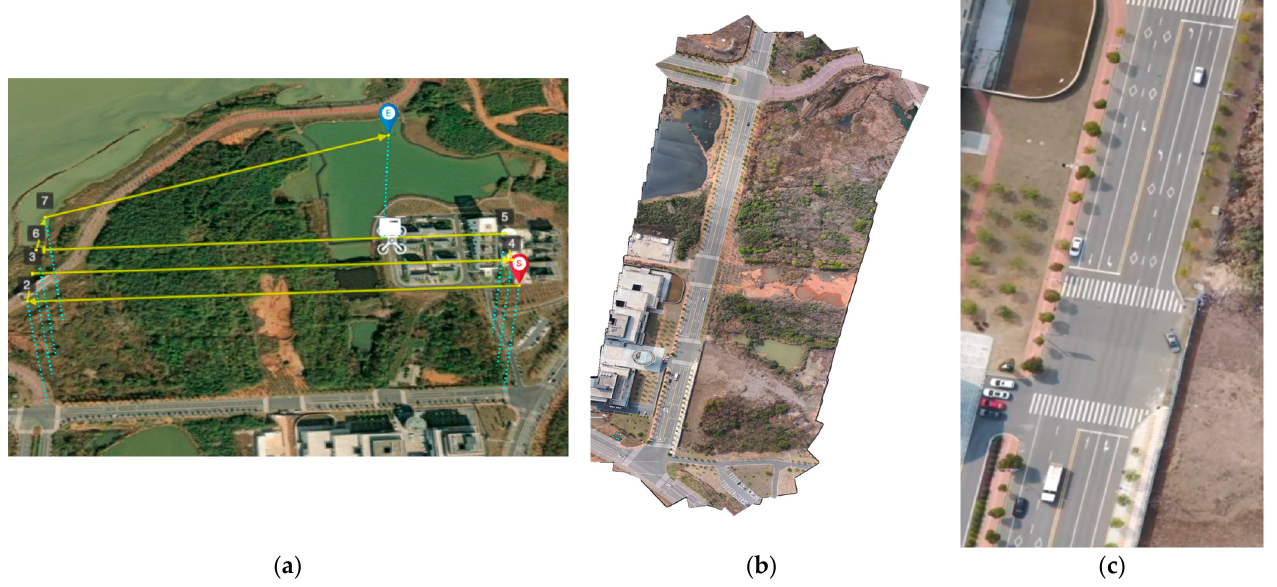
Figure 7. Result of robustness experiment of moving targets. Including ( a ) flight trajectory, ( b ) panorama from our framework and ( c ) detailed close-up of the vehicle.